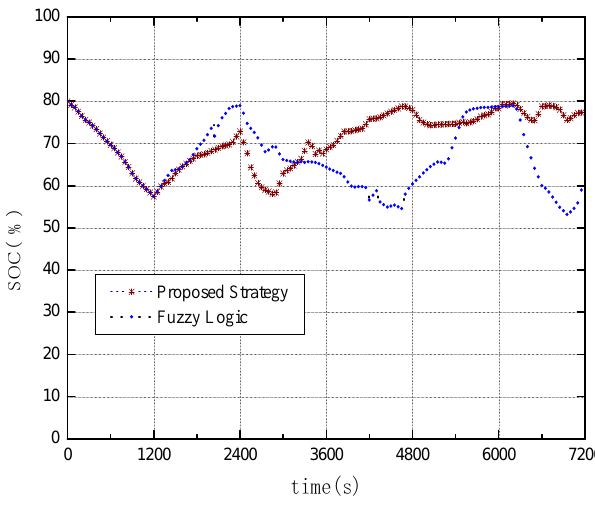
Figure 9. SOC change comparison of the two compared strategies.